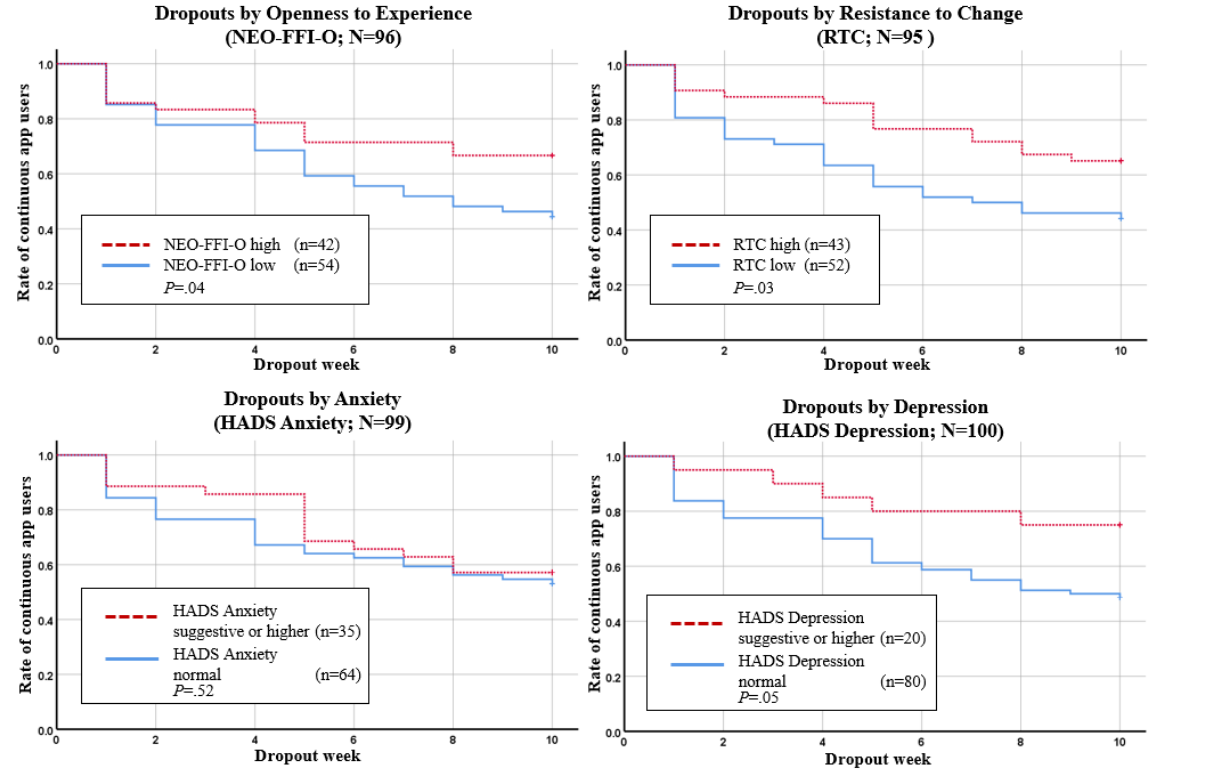
Figure 6. Kaplan-Meier survival curves for continuous app users by openness to experience, resistance to change, anxiety and depression. NEO-FFI-O: NEO Five-Factor Inventory - openness to experience; RTC: Resistance to Change; HADS: Hospital Anxiety Depression